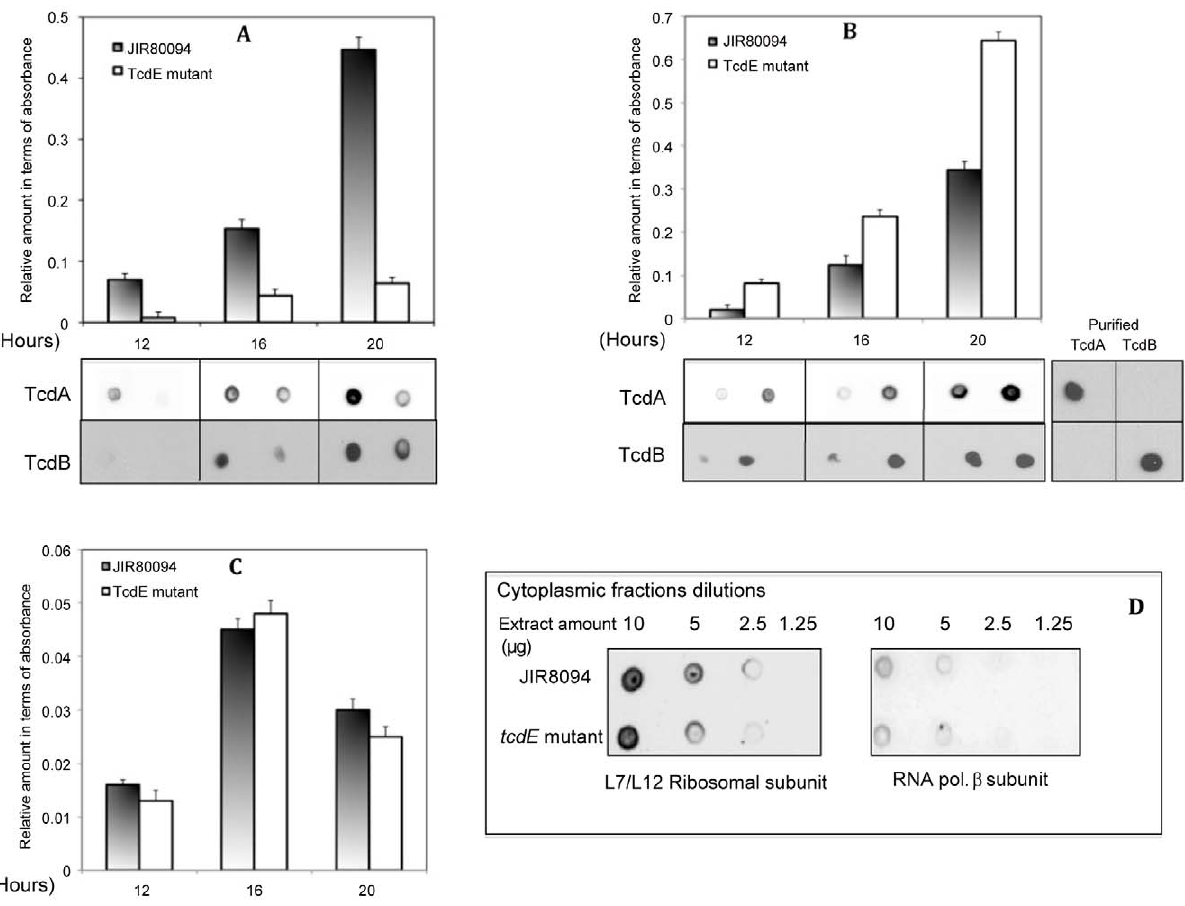
Figure 3. Quantification of toxins and lactate dehydrogenase (LDH) activity in parent JIR8094 and tcdE mutant strains. Toxin titers in the culture supernatants ( A ) and in cytoplasmic proteins ( B ) were determined by ELISA and the signal from the test was recorded as absorbance at 450 nm. The data shown are the mean + / 2 standard error of three replicative samples. Student’s t -test was used for statistical analysis. (*) P -value is , to 0.05. Dot blots with monoclonal anti-TcdA and anti-TcdB are shown in the lower panels. Purified TcdA and TcdB were used as controls. C. LDH activity in the cytoplasmic fraction was determined using Promega CytoTox 96 and was measured as micro units calculated in comparison with standards provided in the kit. D. Cytoplasmic proteins collected from a 16 hours old cultures of parental and tcdE mutant strains were analyzed in dot blots using monoclonal antibodies against L7/L12 ribosomal subunits and the RNA polymerase beta subunit. doi:10.1371/journal.ppat.1002727.g003 mutant DNA but not from the wild-type strain’s DNA (Figure 2A) confirming the insertion of the intron in the tcdE gene.